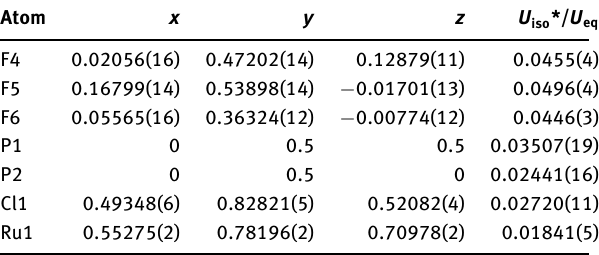
Table 2: Fractional atomic coordinates and isotropic or equivalent isotropic displacement parameters (Å 2